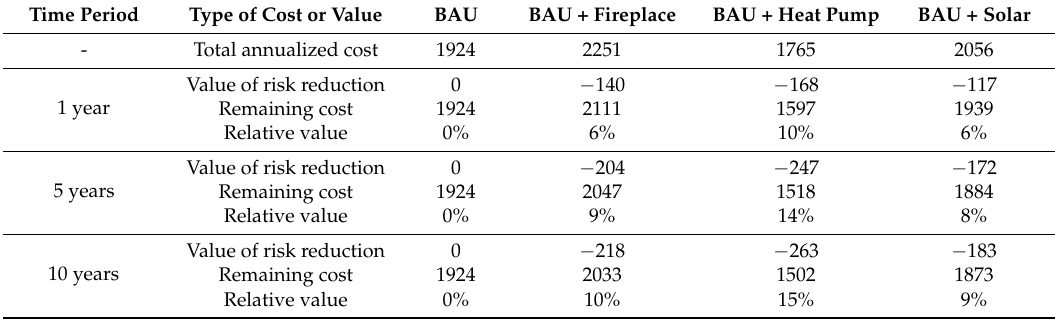
Table 4. Accounting of annualized costs to the investor in the four cases over three different time periods. Total annualized cost ( € /a) shows annualized cost of each type of heating system, value of risk reduction ( € /a) shows the value of risk reduction in each case and time period as a negative cost, remaining cost ( € /a) shows the total cost of the heating system after subtracting the value of price risk reduction and, finally, relative value (%) shows the relative value of price risk reduction compared to the total cost of the heating system in each case and for each time